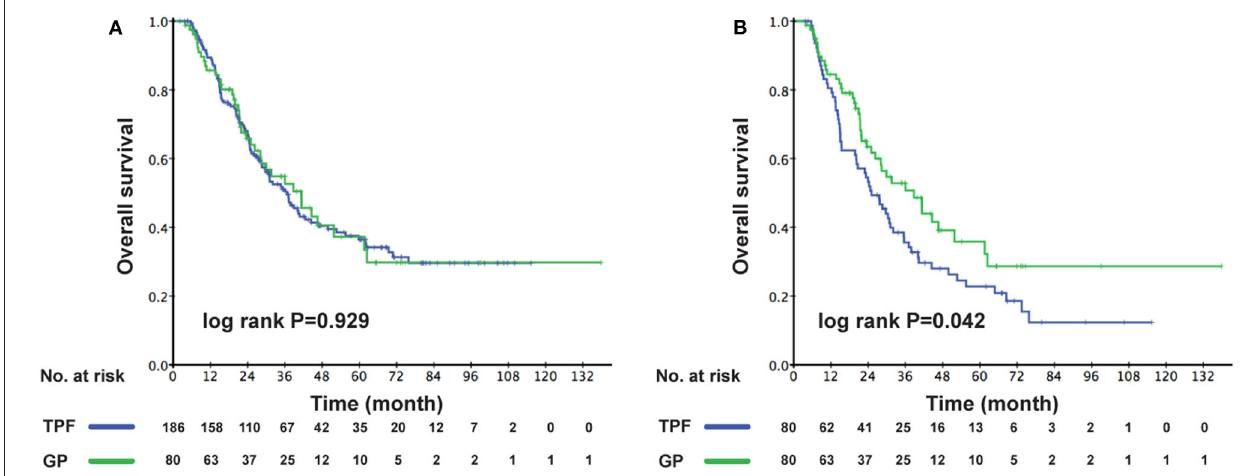
FIGURE 2 | Kaplan–Meier OS curves for the metastatic patients receiving GP and TPF (A) in the whole cohort; (B) in the PSM cohort. OS, overall survival; GP, gemcitabine plus cisplatin; TPF, docetaxel plus fluorouracil plus cisplatin; PSM, propensity score matching.